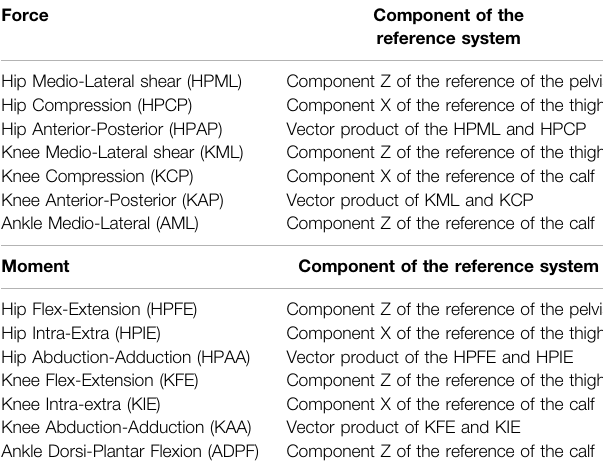
TABLE2| De fi nitionofthedirectionsofeachforceandmomentusedinthestudy. Force